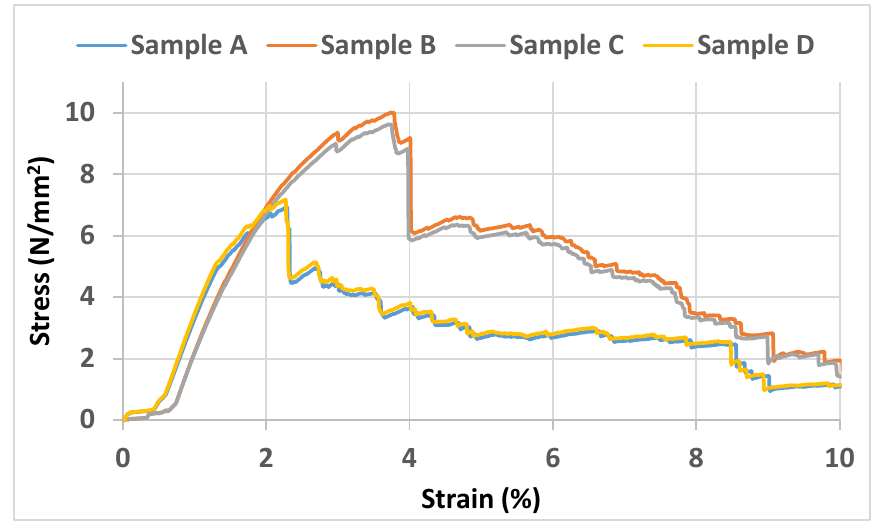
Figure 17. Stress–strain graphs of insulation composites. Table 7. Mechanical properties of insulation composites. Sample No.